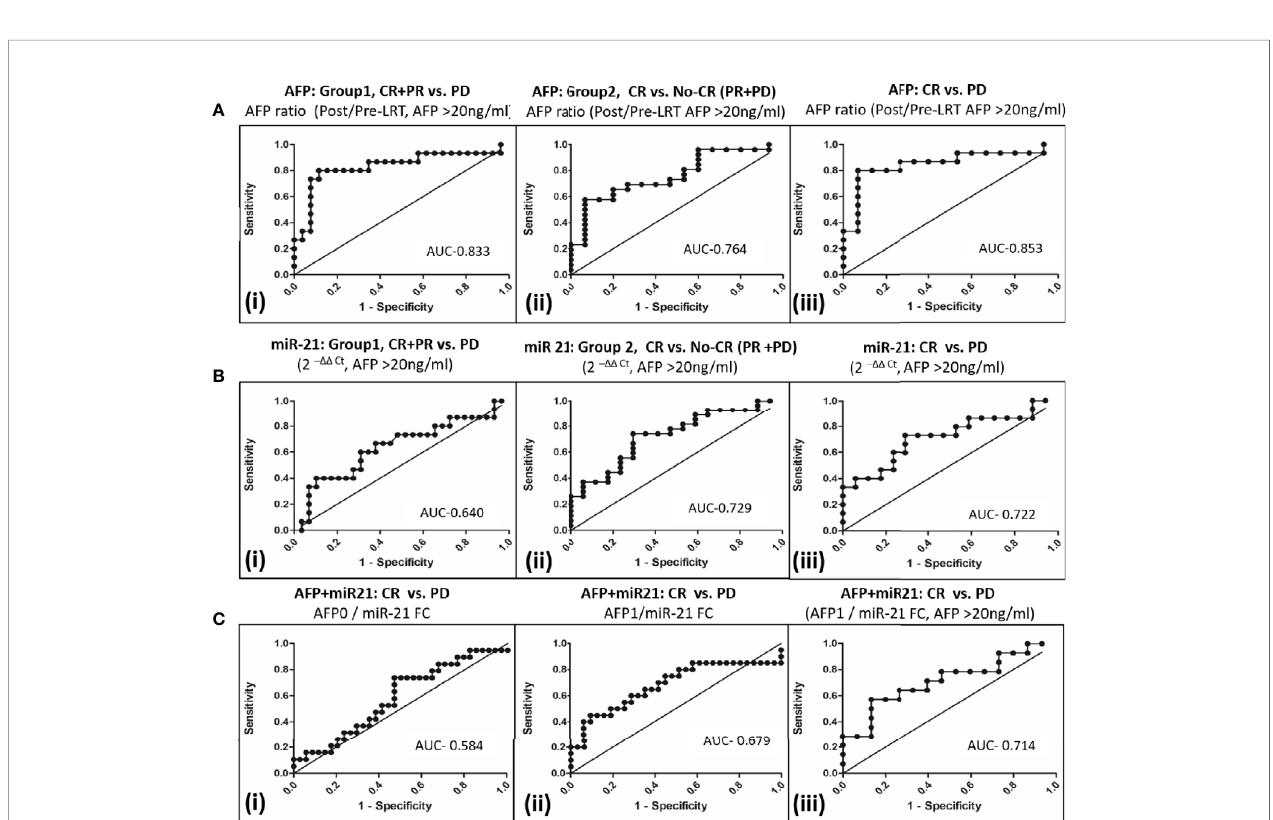
FIGURE 4 | Comparison of AFP and miR-21 fold changes alone or in combination to differentiate tumor response to locoregional therapy in viral-HCC patients. (A) AFP ratio (post/pre-LRT) for differentiating viral HCC in AFP secreting patients (AFP>20ng/ml) in group1 (i), CR+PR vs. PD; group 2 (ii), CR vs. No CR(PR+PD) and (iii) CR vs. PD. (B) Fold change of miR-21 for differentiating viral HCC in AFP secreting patients in group1(i), CR+PR vs. PD; group 2 (ii), CR vs. No CR(PR+PD) and (iii) CR vs. PD. (C) miR-21 and AFP Combination for differentiating viral HCC. Differentiation of CR vs. PD by AFP0/miR-21 FC (i), AFP1/miR-21 FC; (ii) in all HCC patients and AFP1/miR-21 FC in AFP secreting patients